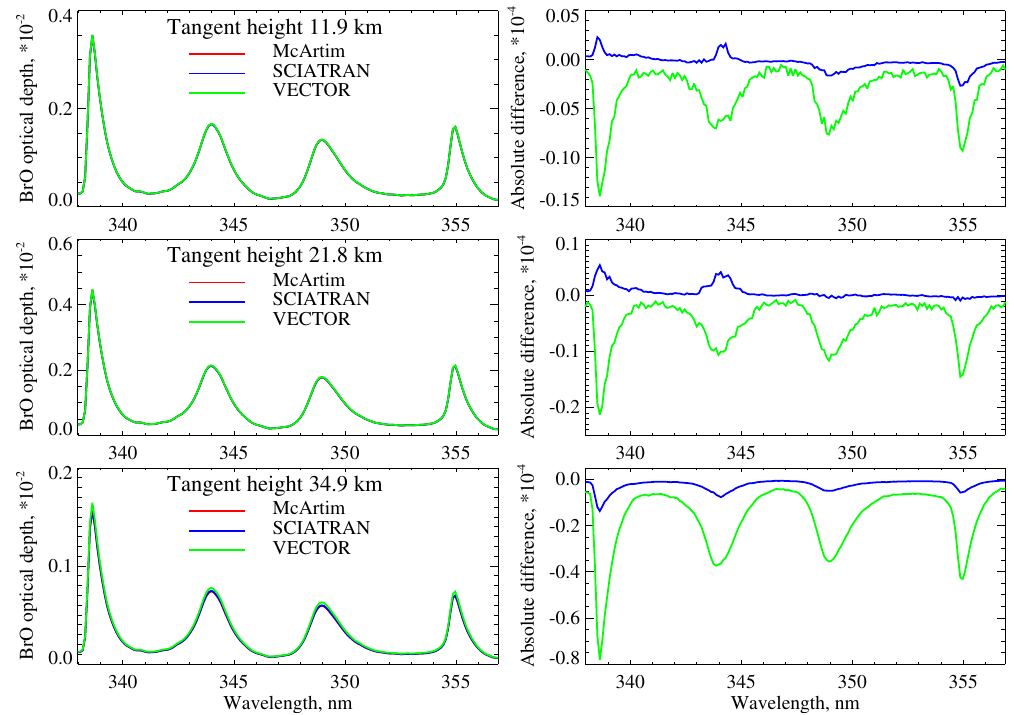
Fig. 9. Same as in Fig. 8 but for an observation geometry typical for tropical winter